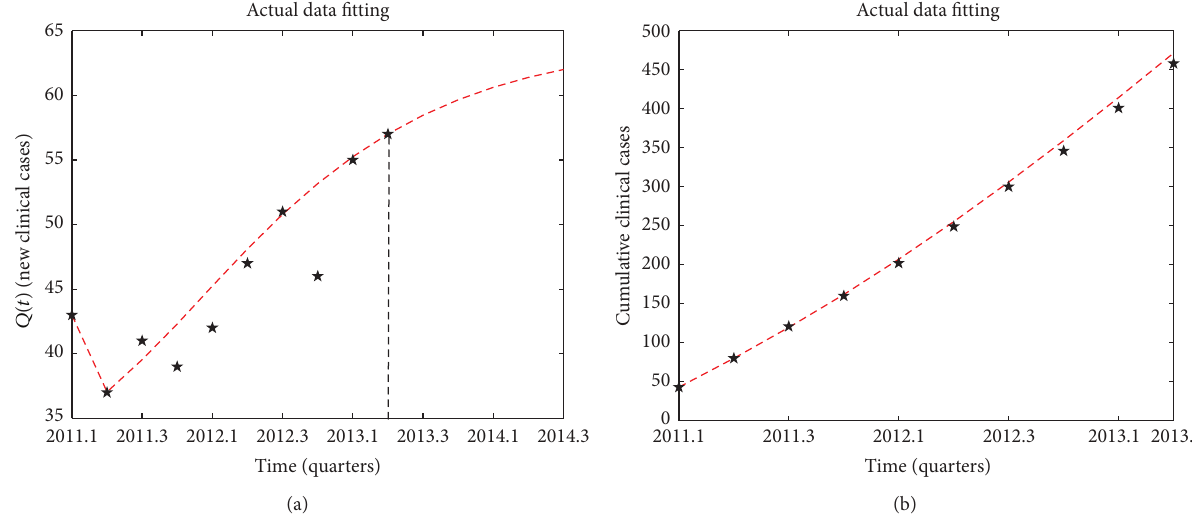
Figure 2: (a) The comparison between the reported clinical cases and the simulation of new clinical cases from system (1). (b) S. suis model fitting for the cumulative clinical